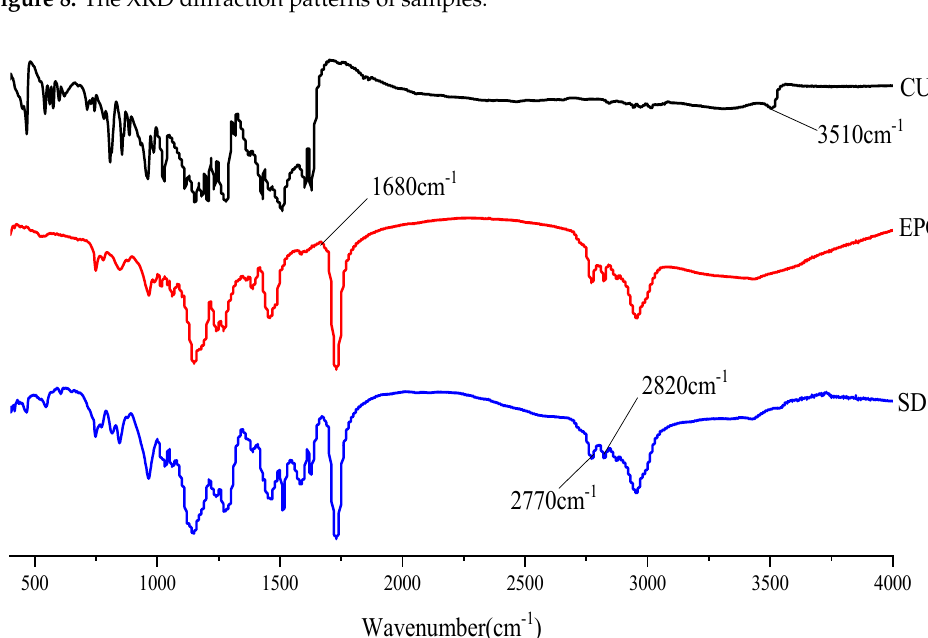
Figure 9. The FTTR spectrum of samples.